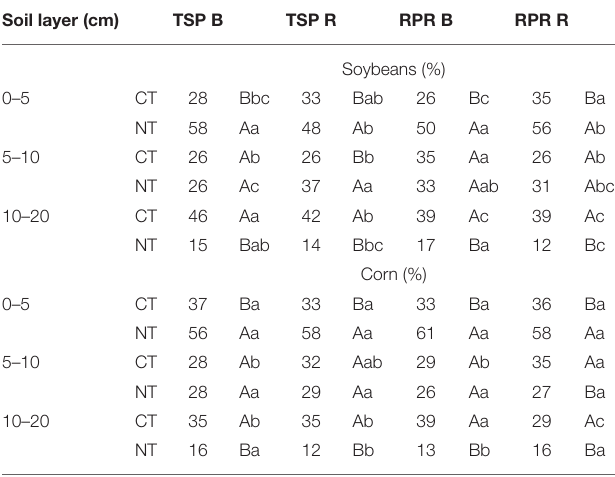
TABLE 4 | Relative distribution (%) of the surface density of soybeans and corn roots in each of the three layers of a very clayey Oxisol under different soil tillage systems and phosphate fertilization